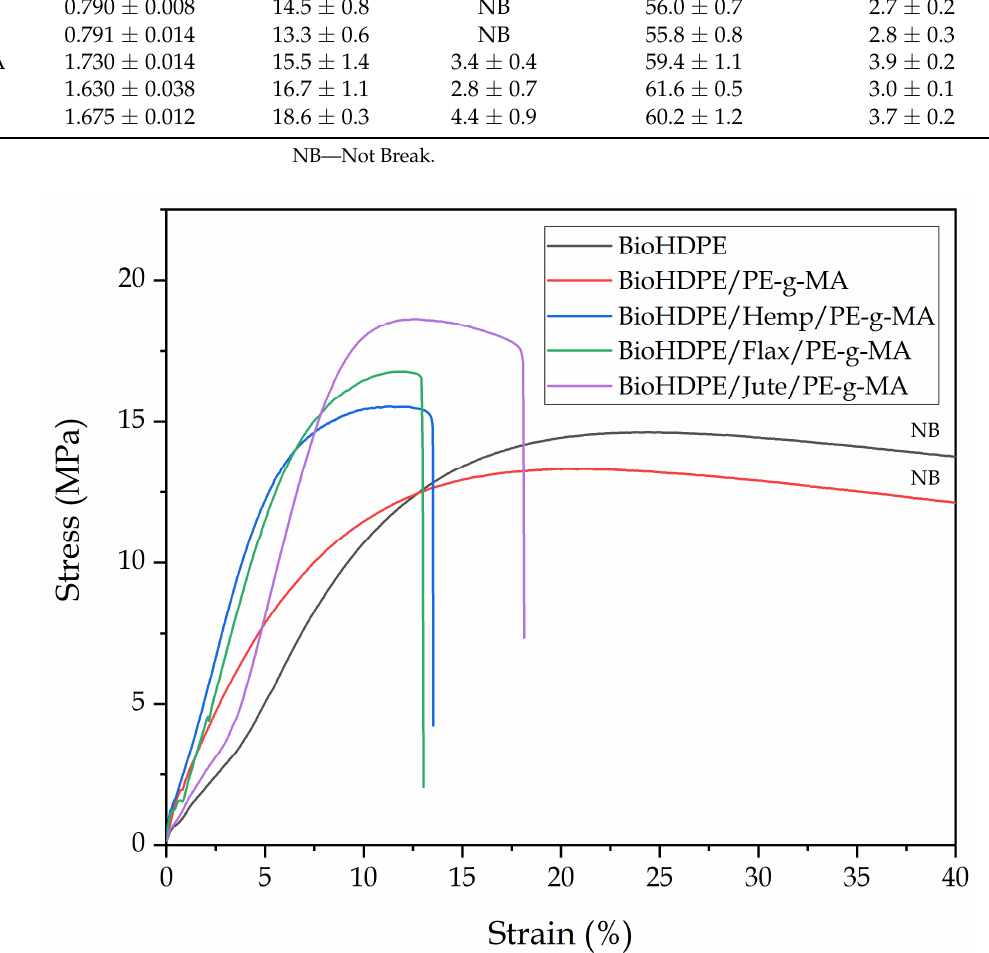
Figure 2. Stress strain curves for all the BioHDPE/PE-g-MA composites reinforced with natural fibers. Table 2. Summary of mechanical properties of the injection-molded parts of BioHDPE-natural fiber composites in terms of: tensile modulus (E), maximum tensile strength ( σ max ), elongation at break ( ε b ), Shore D hardness, and impact strength.